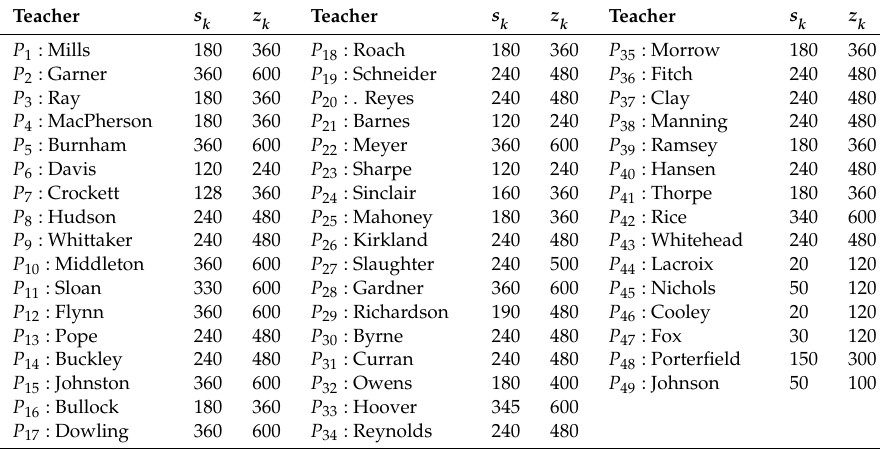
Table 7. FECS teaching sta ff hour limits.